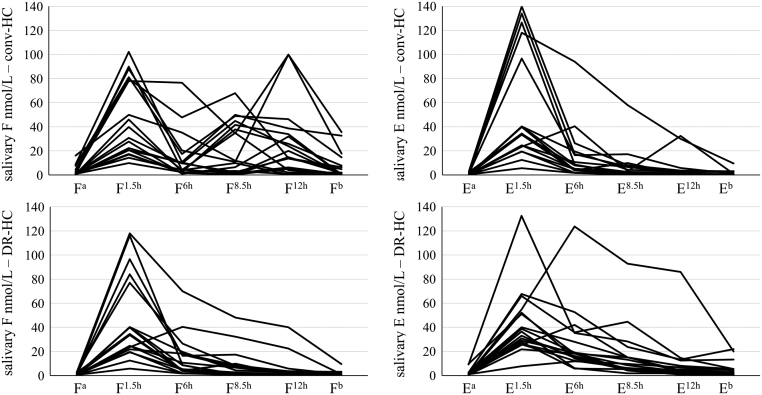
Spaghetti plot of salivary cortisol (F) and cortisone (E) rhythm in patients with conv-HC and DR-HC.